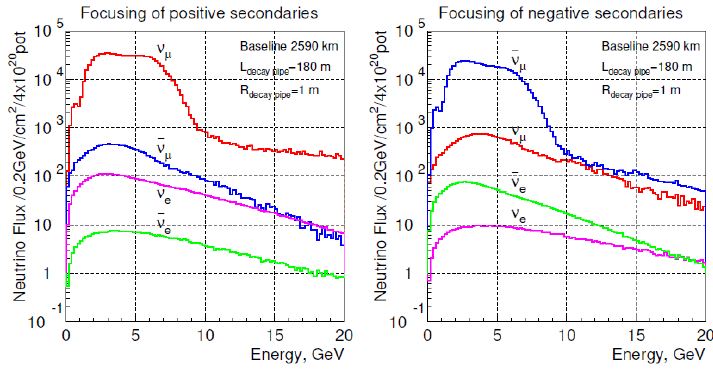
Figure 4. Two horns scheme of the focusing system. Horn currents are equal to 220 kA. Figure 6. Neutrino (left) and antineutrino (right) spectra at the ORСA site.